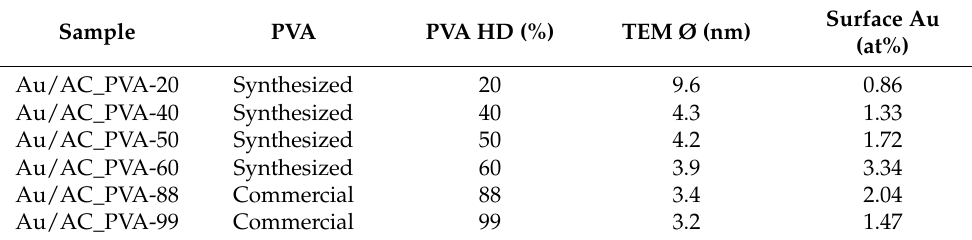
Table 1. TEM and XPS analysis of the synthesized fresh catalysts along with their main characteristics. PVA: origin of the polymer used as stabilizing agent, either commercial or synthesized ad hoc; PVA HD: hydrolysis degree of the polymer used; TEM Ø: mean Au particle size, measured via TEM; Surface Au: gold percentage of surface atoms, measured via